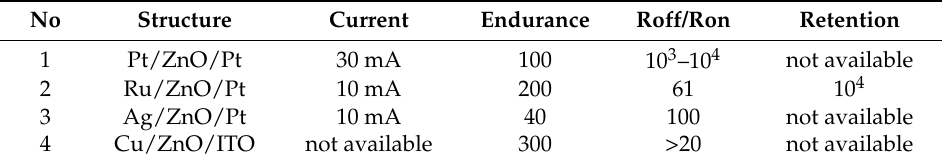
Table 1. ZnO-based resistive random access memory fabricated with various metal